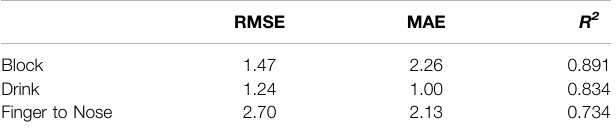
TABLE 1 | Root mean square error (RMSE), mean absolute error (MAE), and coef fi cient of determination ( R 2 ) of the T ’ ena system to the ground-truth Vicon motion capture